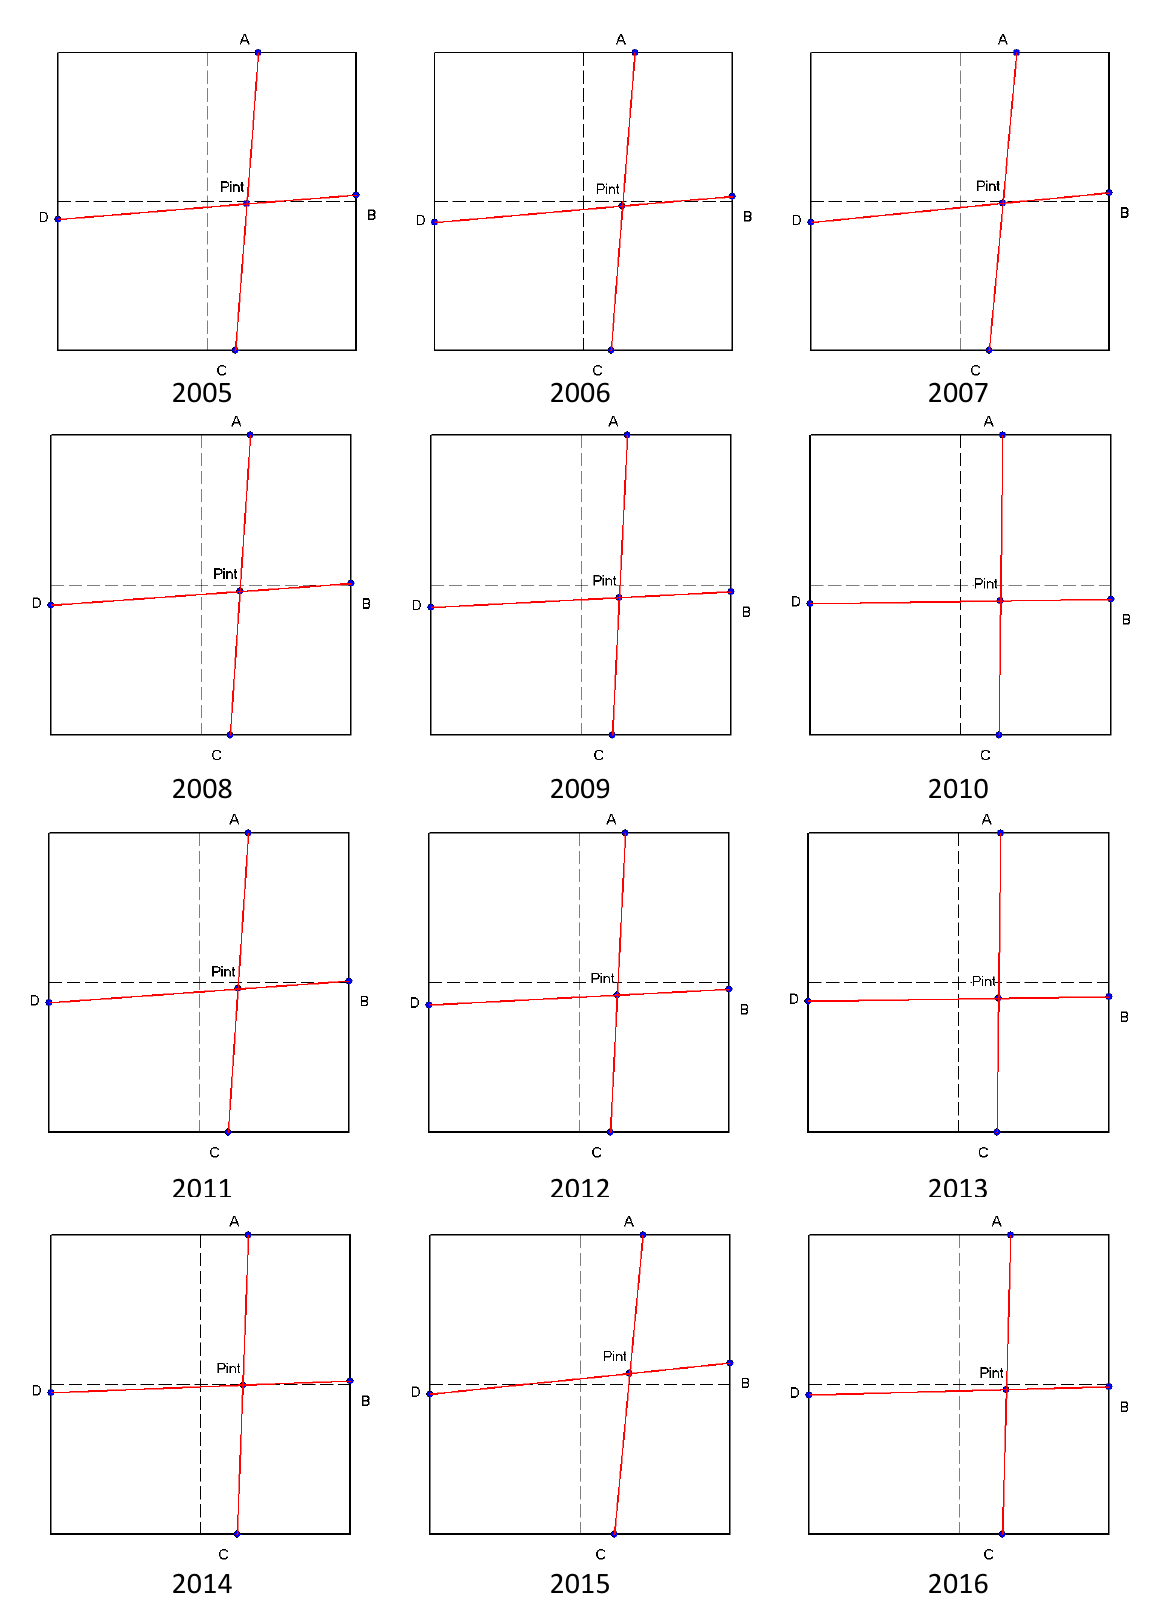
Figure 2. Graphical models of the enterprise subsystems structure by year for the 2005–2016 period (generalized by the group of